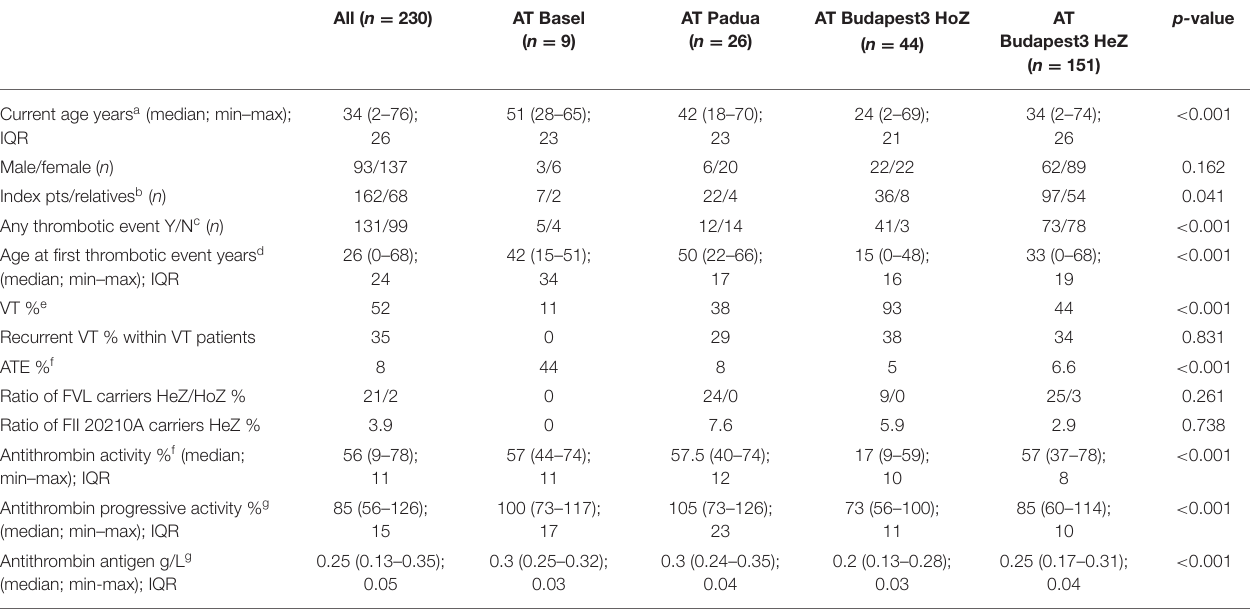
TABLE 3 | Clinical and laboratory characteristics of the type IIHBS antithrombin-deficient cohort.